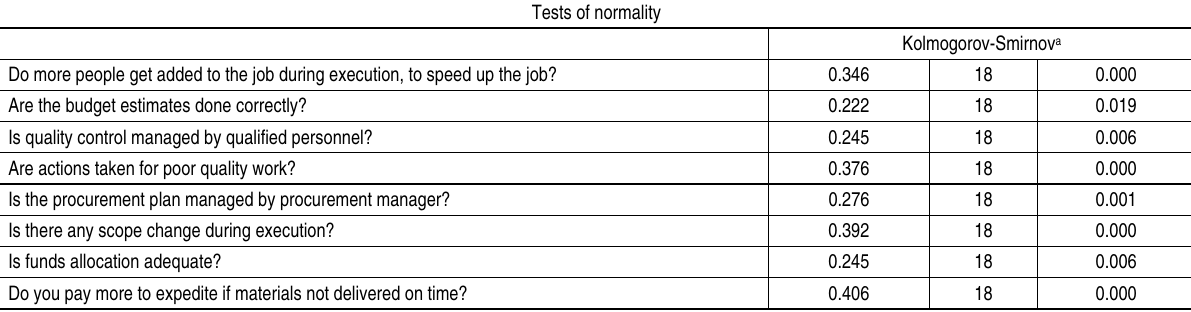
Table 2 (cont.). Kolmogorov-Smirnov Z test for normality